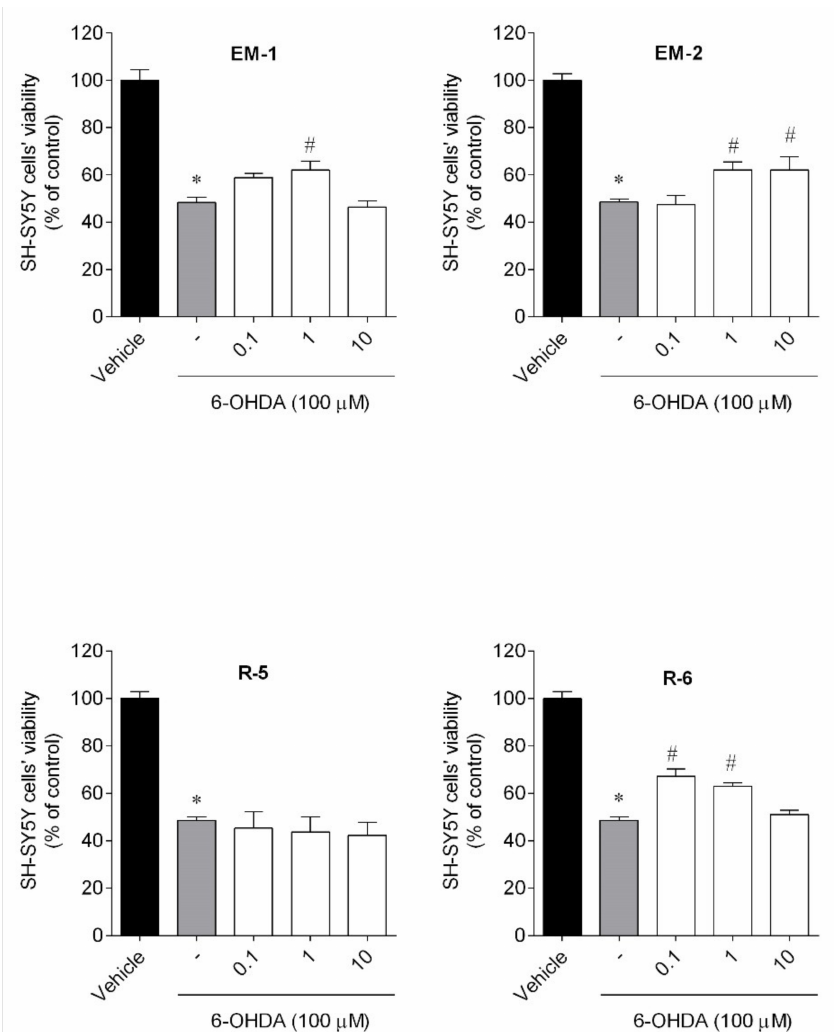
Figure 4. Neuroprotective effects on SH-SY5Y cells treated with 6-OHDA (100 µ M) in the pres- ence/absence of peptides (0.1–10 µ M, 24 h). The values in each column represent the mean ± SEM of 3 or 4 independent experiments. Symbols represent significant differences (ANOVA, Dunnett’s test, p < 0.05) when compared to: * vehicle and # 6-OHDA. (-)